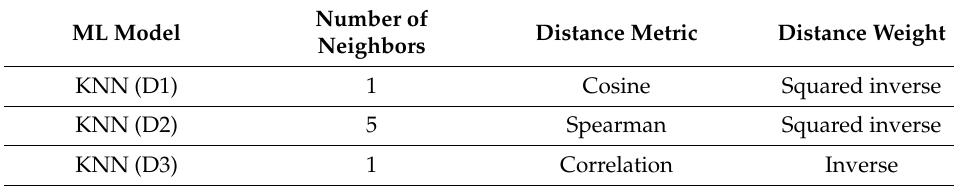
Table A6. K-Nearest Neighbors: optimized hyperparameters for each